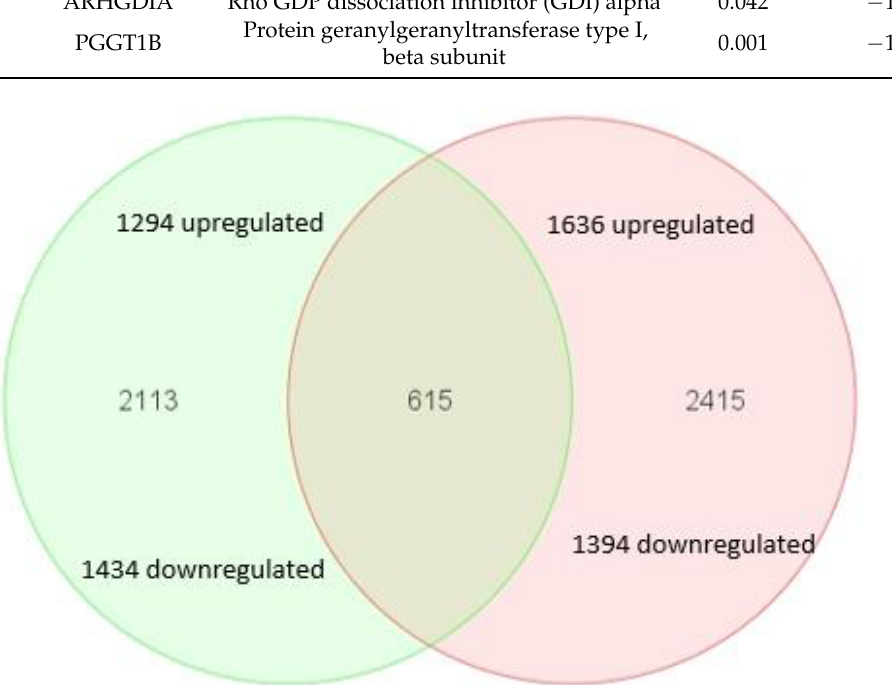
Figure 1. Venn diagram of HUVECs genes that were significantly expressed after culturing for 24 h in 0.1 mM MgSO 4 , indicated by green, and 5 mM MgSO 4 , indicated by red, as compared to 1 mM MgSO 4 . 615 genes were differentially expressed relative to control in both conditions. Table 1. List of top 20 genes based on fold change that were differentially expressed in HUVECs culture in 0.1 mM MgSO 4 .